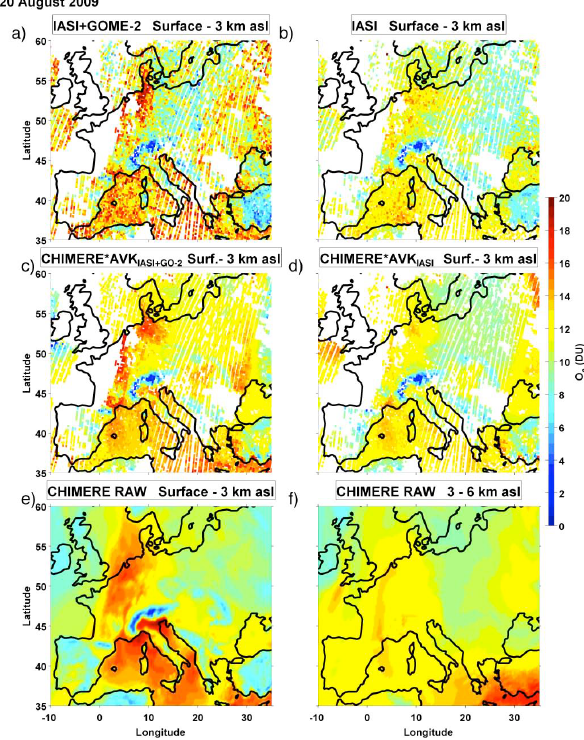
Fig. 11. Same as Fig. 10, but for 20 August